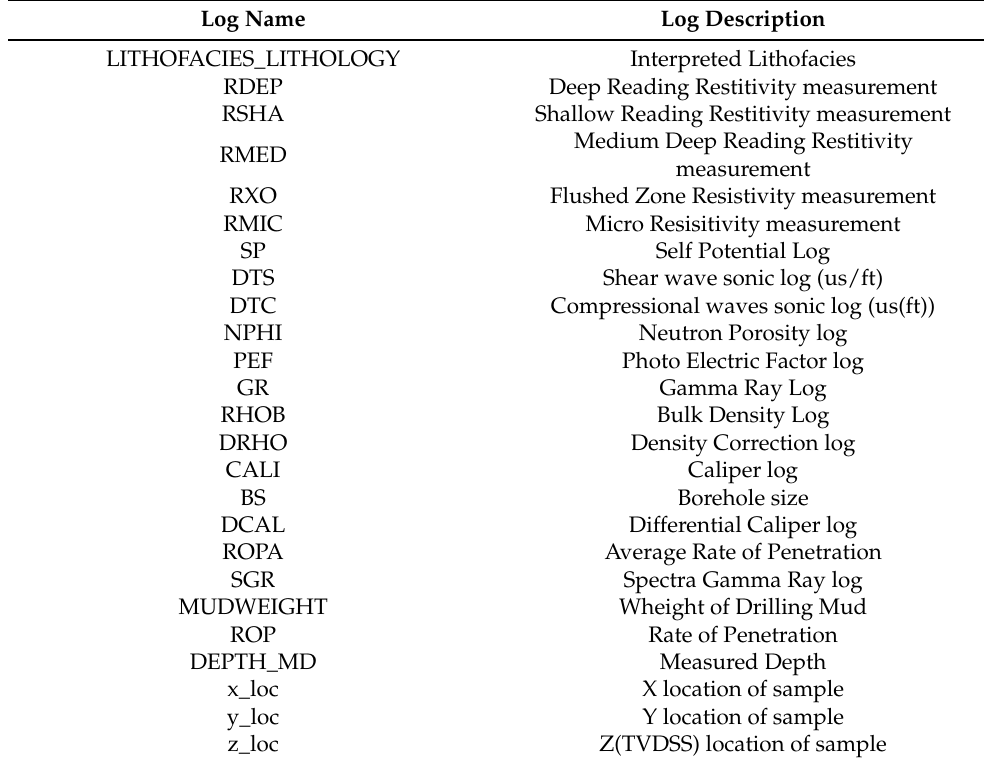
Table 1. The well log abbreviations.